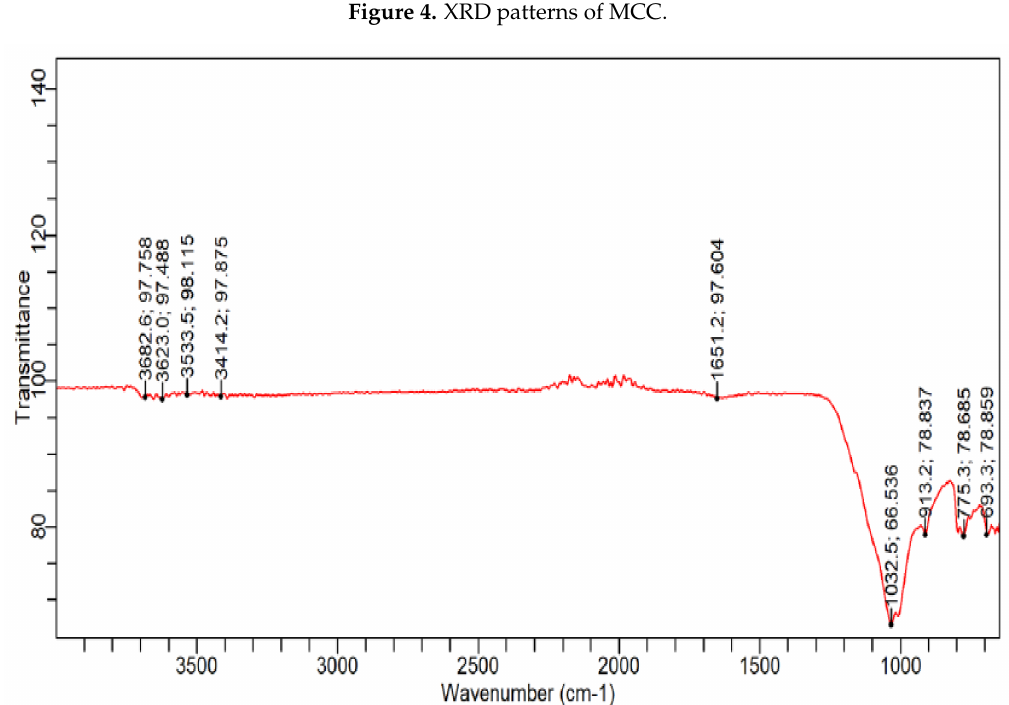
Figure 4. XRD patterns of MCC.